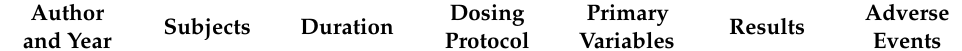
Table 4. Summary of selected studies examining the long-term (>2 weeks) effects on strength